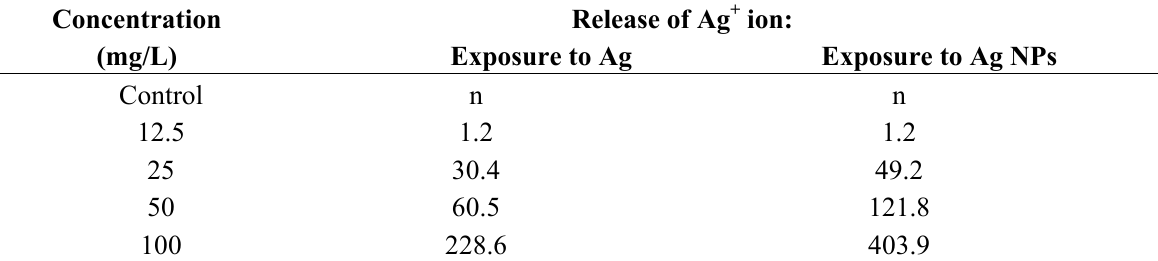
Table 1. Mean release of Ag + ions (mg/L) to the DI-water: n = not measurable.